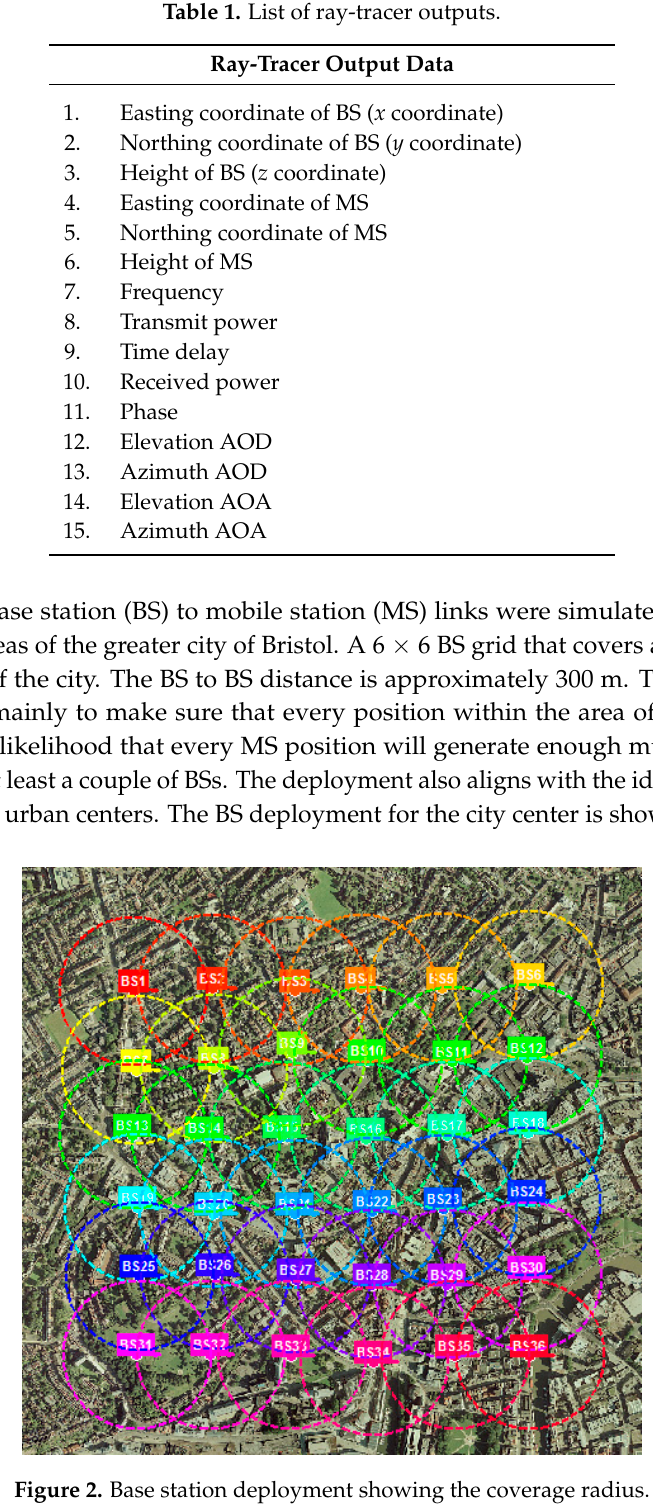
Table 1. List of ray-tracer outputs.